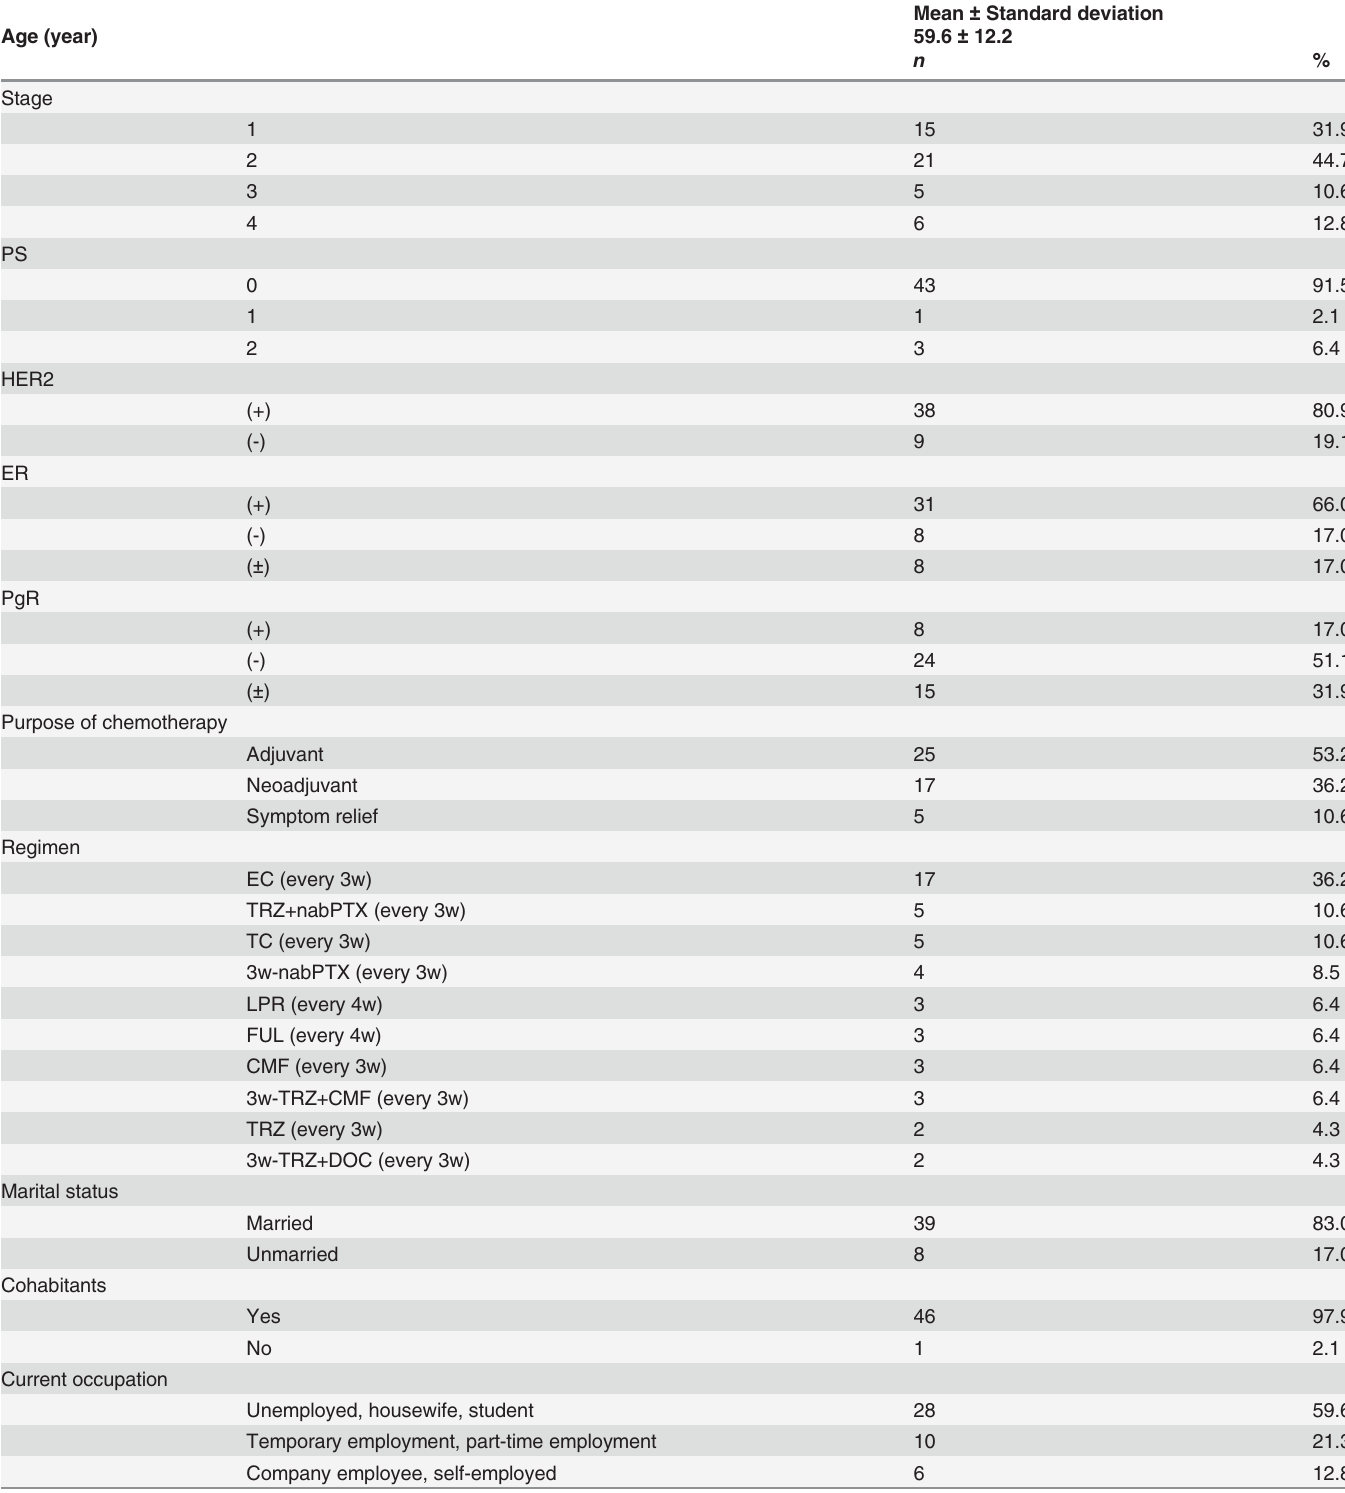
Table 1. Patient